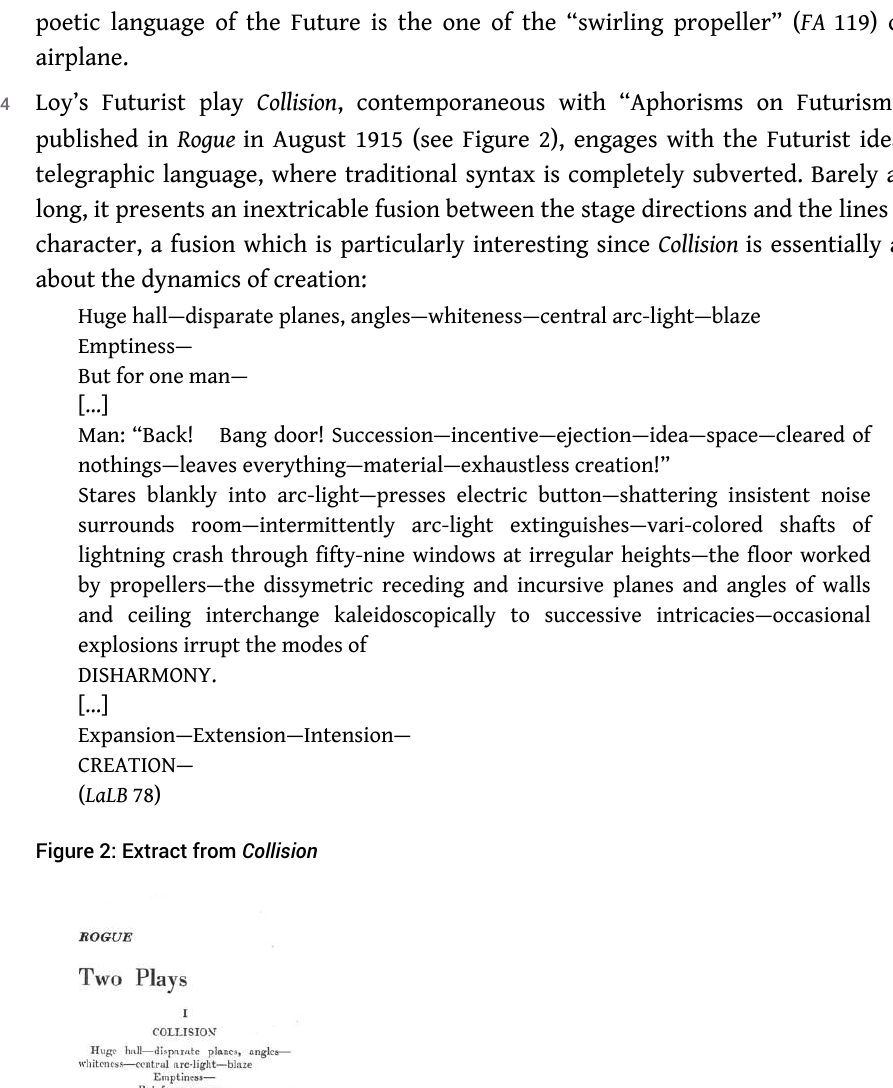
Figure 2: Extract from Collision